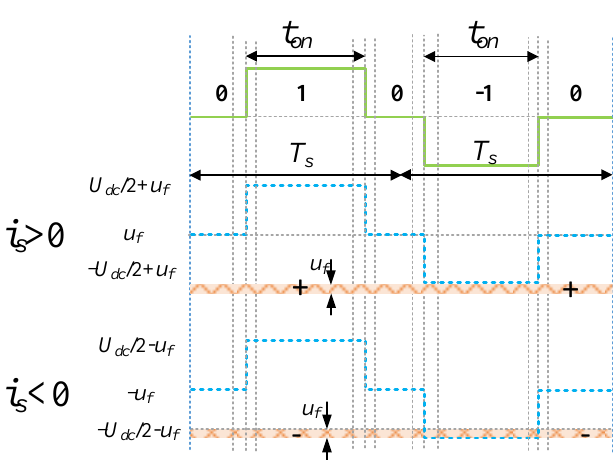
Figure 5. The forward voltage drops in different current directions.